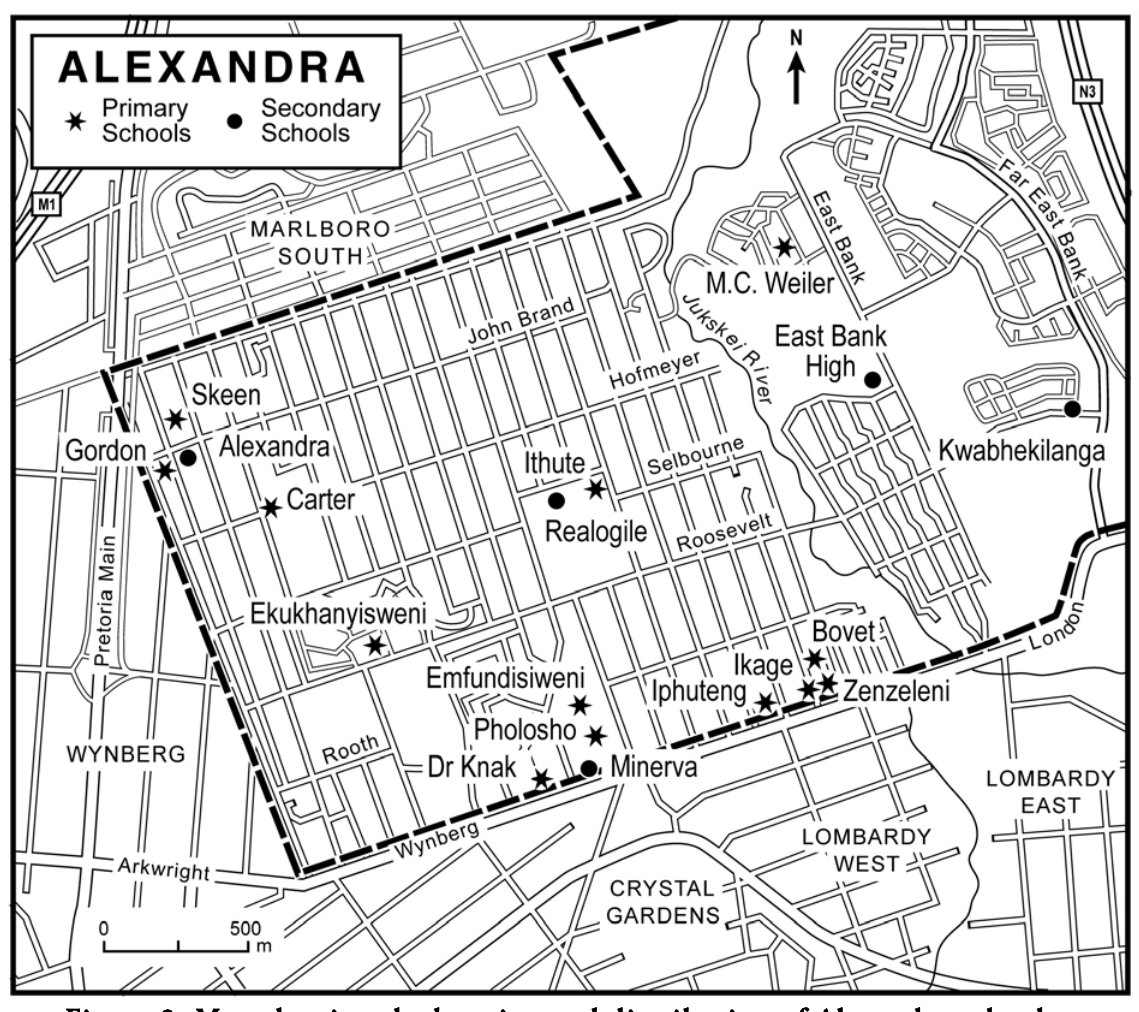
Figure 2: Map showing the location and distribution of Alexandra